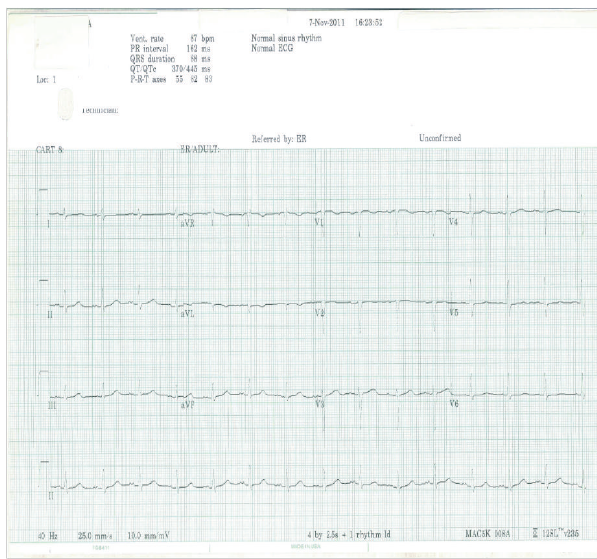
Figure 1: ECG representing isolated T wave inversion in lead aVL.